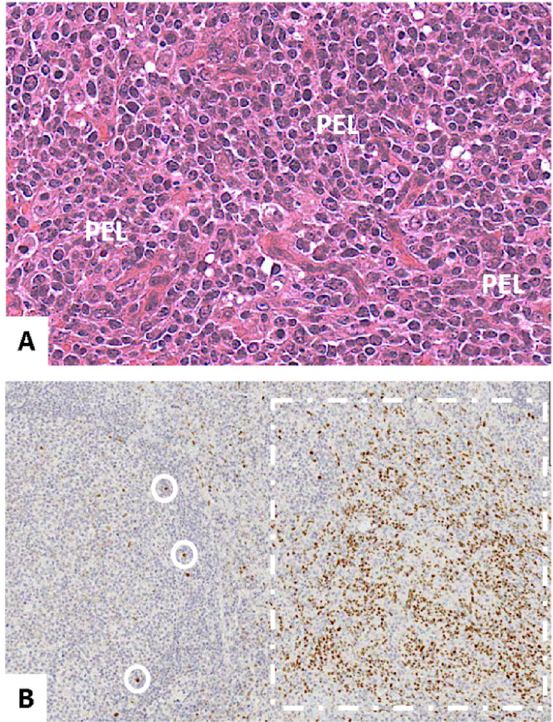
Figure 2. KSHV/HHV8-associated MCD and solid PEL. ( A ) The figure shows large atypical lym- phoid cells with plasmablastic morphology, consistent with solid PEL. The tumour cells are negative for CD20 and variably positive for CD138 and CD30 (not shown). ( B ) This lymphoma is involving the lymph node in the interfollicular zone of the lymph node (dashed). Neoplastic cells are positive for LANA. In the follicular mantle, some large, atypical cells, consistent with plasmablasts, are also positive for LANA (circled). Magnification ×40 ( A ), ×20 ( B ).